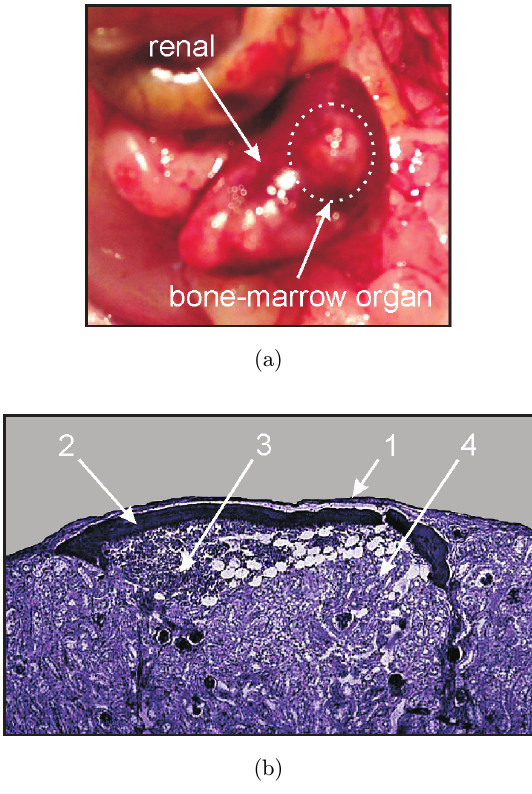
Fig. 3. Microphotograph of a bone marrow organ formed under a renal capsule: 1 is renal capsule; 2 is bone capsule; 3 is bone marrow; 4 is renal tissue.